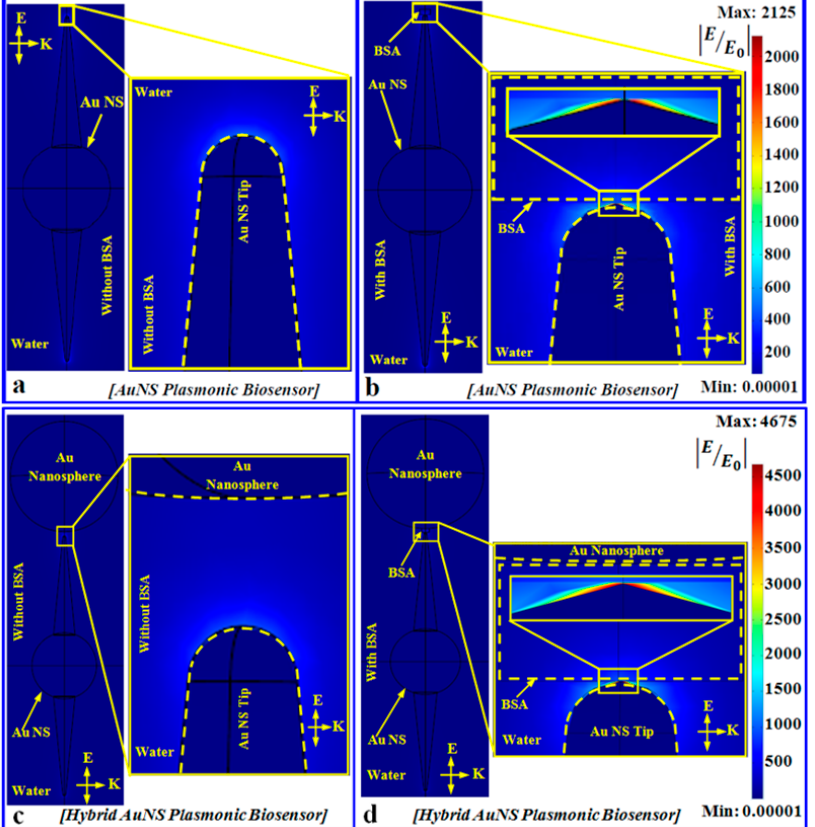
Figure 5. ( a ) Interaction of single AuNS plasmonic biosensor dispersed in water with incident light in the absence of a BSA molecule. The zoomed portion of the yellow box shows the intensity enhancement at the pinnacle of the spike. ( b ) Interaction of a single AuNS plasmonic biosensor with incident light in the presence of BSA in water media. ( c ) Photon interaction of a hybrid plasmonic biosensor developed from a single AuNS and an Au nanosphere in the absence of BSA immersed in water. ( d ) Interaction of a hybrid plasmonic sensor with incident light in the presence of BSA in water media. Here in all cases, the incident light wave has polarization along the z-axis and propagation along the +y direction. The AuNS has a spike length of 88 nm and a 60 nm core, and the size of the Au nanosphere is 100 nm.